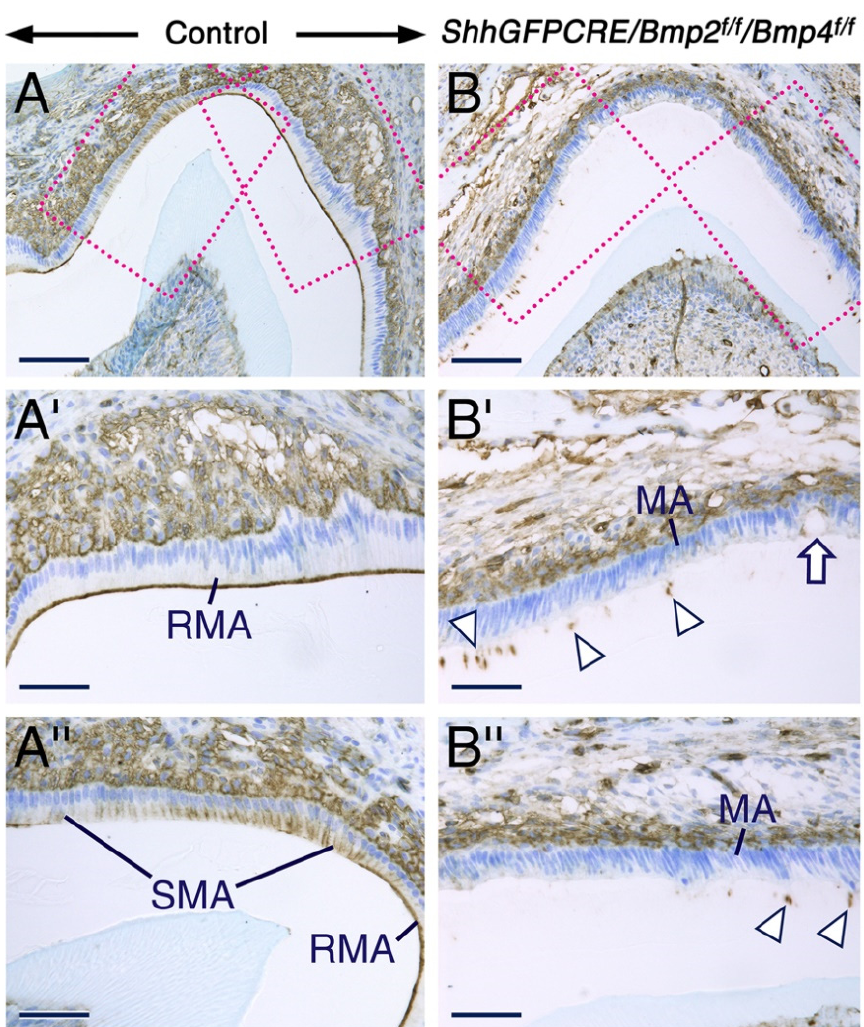
Figure 3. BMP2- and BMP4-deficient maturation-stage ameloblasts show cell-matrix and cell-cell contact anomalies and fail to exhibit a ruffled apical plasma membrane. ( A , B ) Representative sec- tions across molars from 12 days post-partum control ( A ) and ShhGFPCRE/Bmp2 f/f /Bmp4 f/f mutant ( B ) mice after immunostaining (brown) for anti-phosphorylated ezrin/radixin/moesin (P-ERM). ( A’ , B’ , A’’ ) and ( B’’ ) are magnified views of the boxed areas in ( A ) and ( B ). In control teeth, P-ERM immunostaining decorates the ruffled apical plasma membrane of ruffle-ended maturation-stage ameloblasts (RMA) and is concentrated in the lateral membranes (at cell-cell adhesion contacts) of smooth-ended maturation-stage ameloblasts (SMA). By contrast, in mutant teeth, P-ERM is present only in cellular fragments embedded in the retained enamel matrix (Arrowheads in ( B’ ) and ( B’’ )) and around microcysts within the ameloblast layer (arrow in ( B’ )), indicating failure of development of the ruffled apical plasma membrane and abnormal cell-cell contacts and cell-extracellular matrix attachment. Note the disorganization and abnormal attachment of the apical membrane of the mu- tant maturation-stage ameloblasts to the enamel matrix ( B , B’ , B’’ ). MA, maturation-stage amelo- blasts; RMA, ruffle-ended maturation-stage ameloblasts; SMA, smooth-ended maturation-stage ameloblasts. Scale bars: 100 µm ( A , B ) and 50 µm ( A’ , B’ , A’’ , B’’ ). These data show that the mutant maturation-stage ameloblasts have altered cell-cell